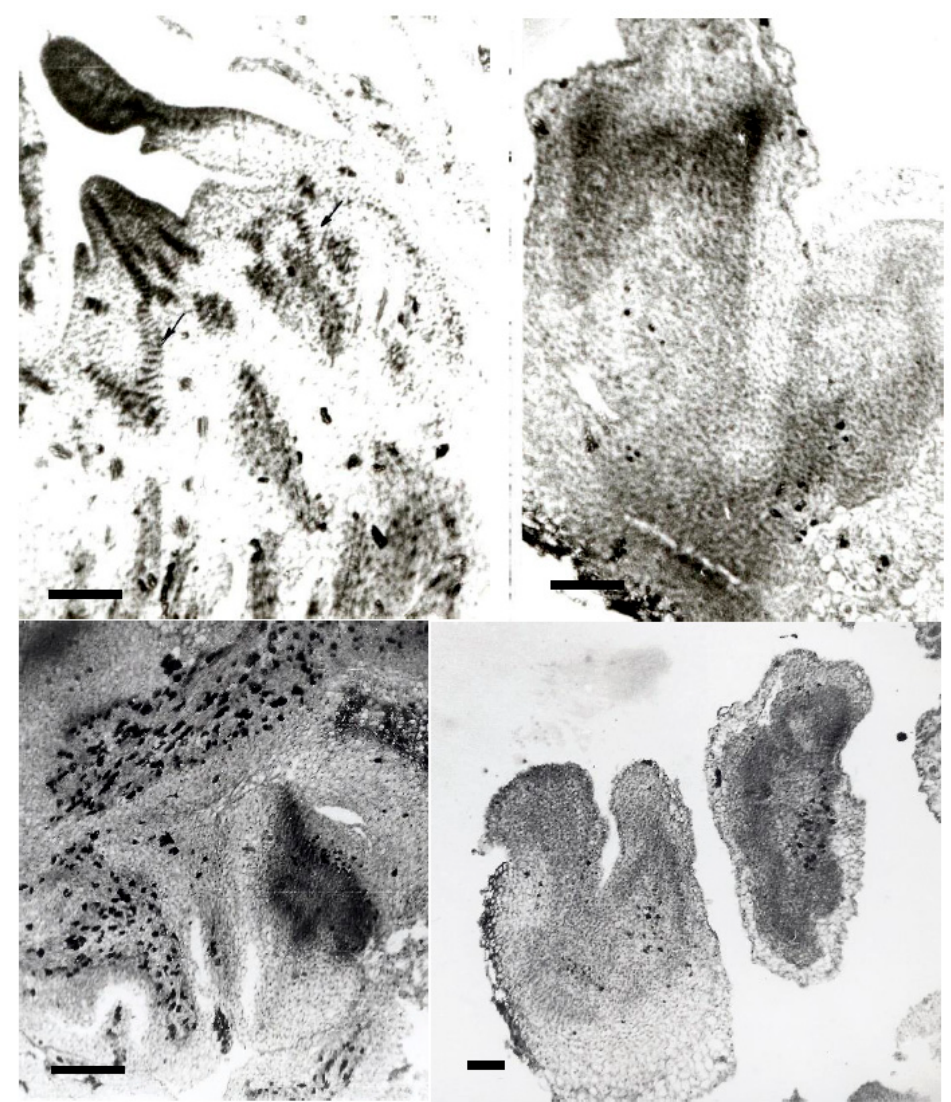
Figure 3. Histological analysis of slide images taken for S. podophyllum callus obtained in the N69 culture medium. Shoots and protocorms forming callus were observed. Nodular-like structures could also be observed (lower-left image), where organogenesis was taking place. The black arrows indicate very well-developed XTEs in the vicinity of a meristematic dome and de novo shoot formation. The meristematic dome is very well expressed, with well-developed, asymmetric, primordial leaves. In the upper- and lower-right images, protocorms can be observed in transversal section (magnification × 135 (upper and lower left) and × 270 (upper right), bars = 100 µm).